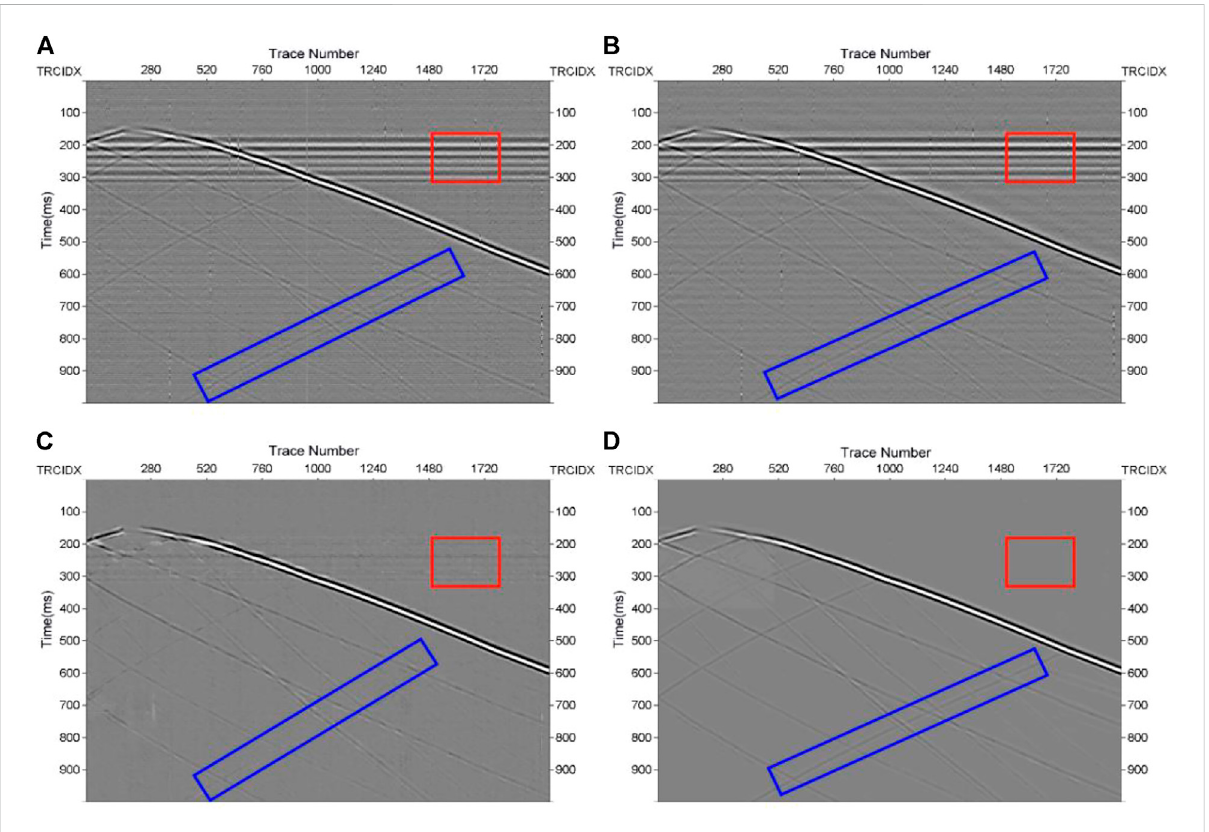
FIGURE 6 Comparison of different methods for synthetic denoising. (A) Denoised result of VMD, (B) denoised result of band-pass fi ltering, (C) denoised result of DnCNNs, (D) denoised result of